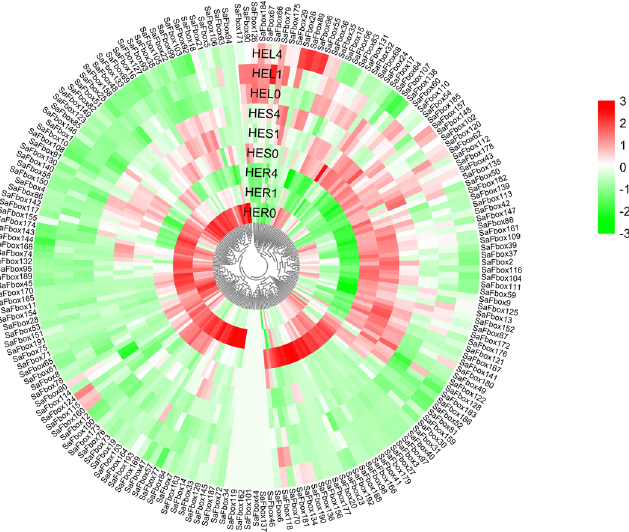
Figure 7. SaFbox expression patterns in various tissues response to Cd stress. The normalized RPKM values of the expressed genes were log2-transformed; Color scale at the left represents the expression levels authorized by Z-Score